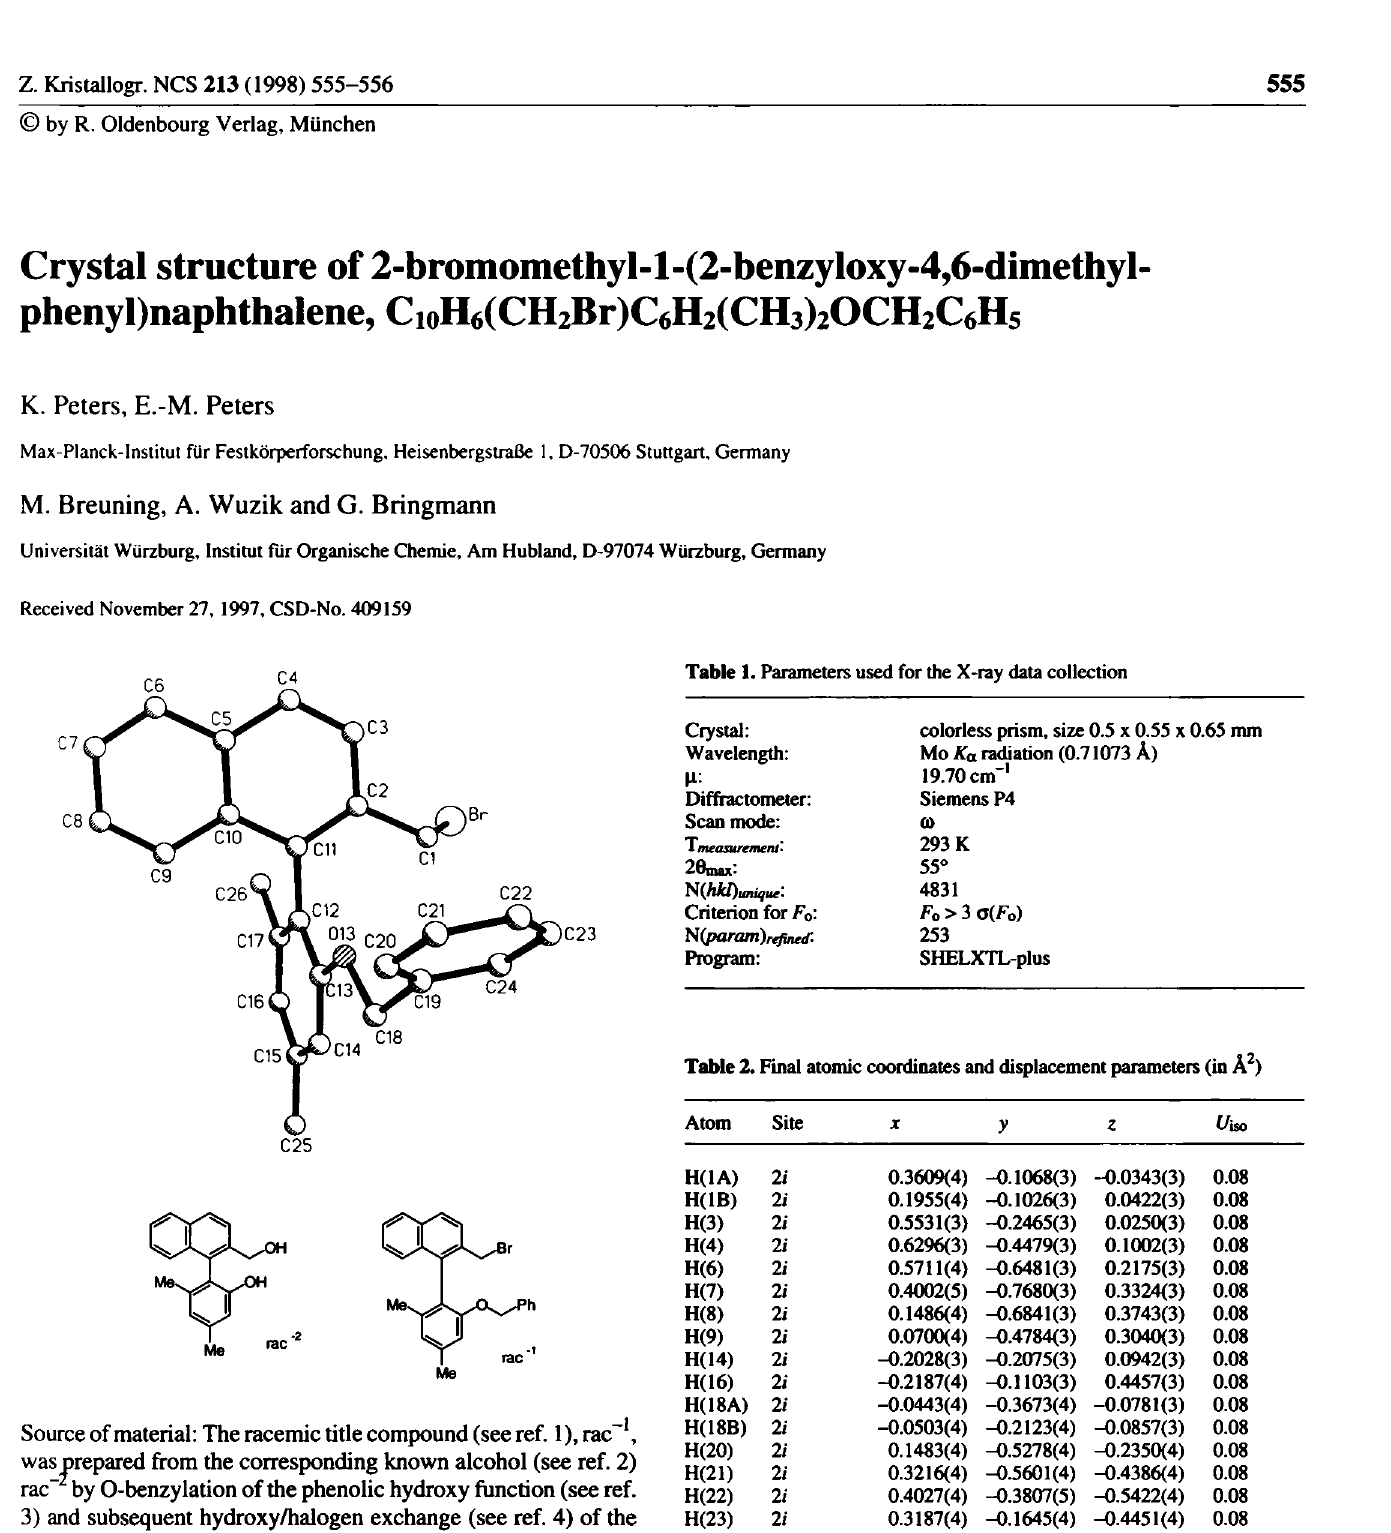
Me Source of material: The racemic title compound (see ref. l),rac~', was prepared from the corresponding known alcohol (see ref. 2) rac~ by 0-benzylation of the phenolic hydroxy function (see ref. 3) and subsequent hydroxy/halogen exchange (see ref. 4) of the benzylic alcohol function (see scheme).